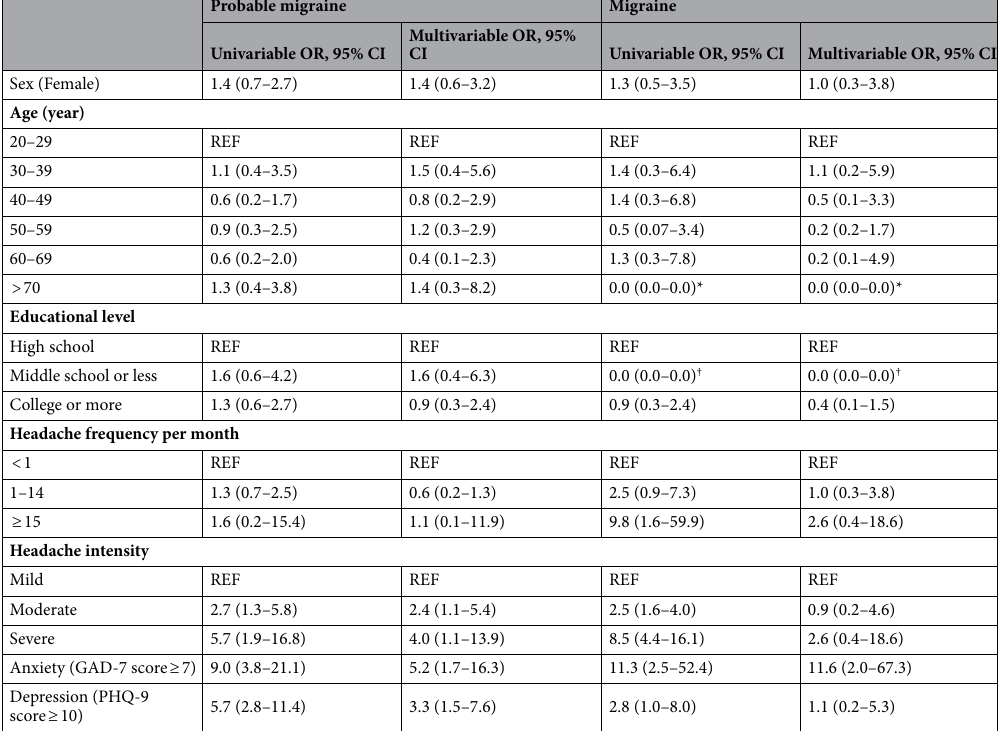
Table 4. Factors associated with cutaneous allodynia in individuals with probable migraine in univariable and multivariable analyses. OR: odds ratio, CI, confidence interval, GAD-7: Generalized Anxiety Disorder-7, PHQ- 9: Patient Health Questionnaire-9. REF: Reference. *No participant with migraine aged > 70 had cutaneous allodynia. † No participant with migraine had an educational level of middle school or